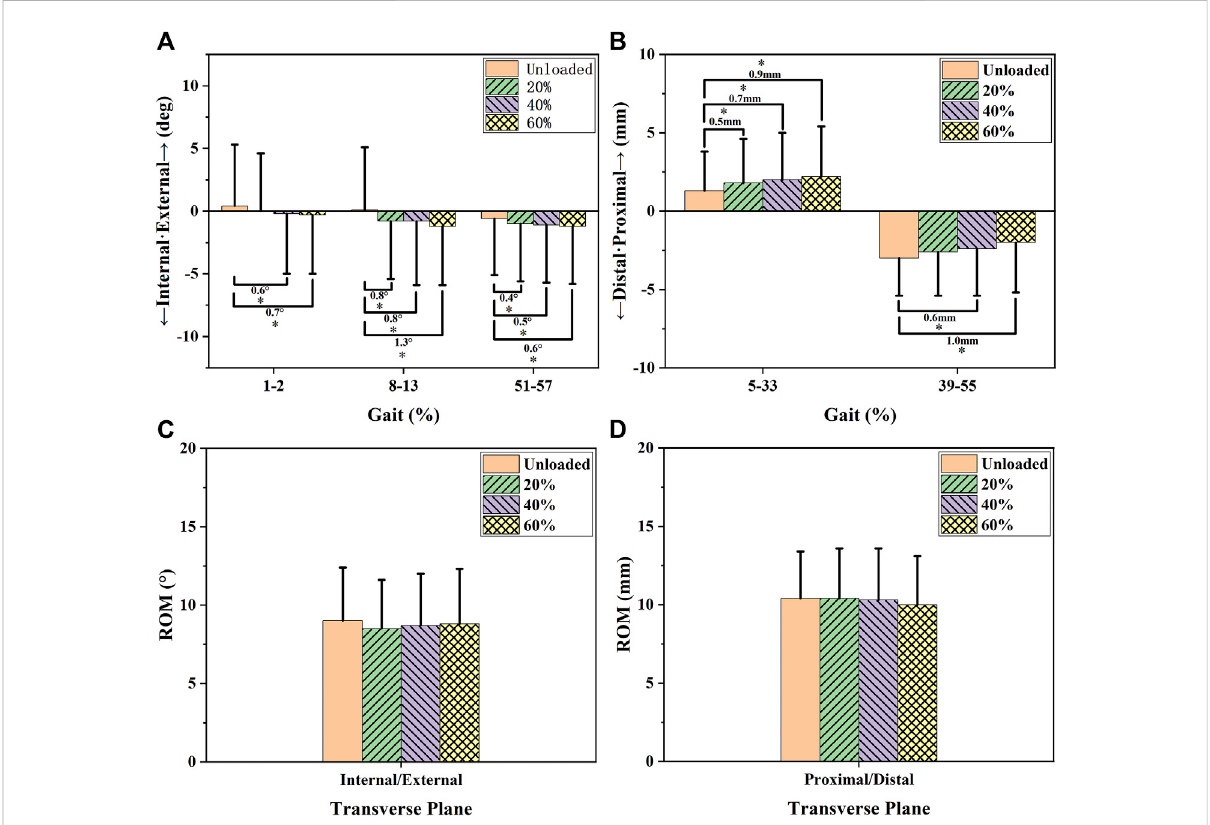
FIGURE 6 TransverseROMand average kneekinematic alterations during the phasesaffected byincreased load levels. Charts (A and B) show theaverage knee kinematics of the affected phases (i.e., the phases marked by colored bars in Figure 2) under increased load levels. Charts (C and D) show the ROM of the transverse knee kinematics under increased load levels. The differences in the knee kinematics between the unloaded state and load levels of 20, 40, and60%BW werecompared usingastatisticalsigni fi cance level of 0.05. The numberand *in thechart represent differences in magnitude and signi fi cant differences between the groups ( p <